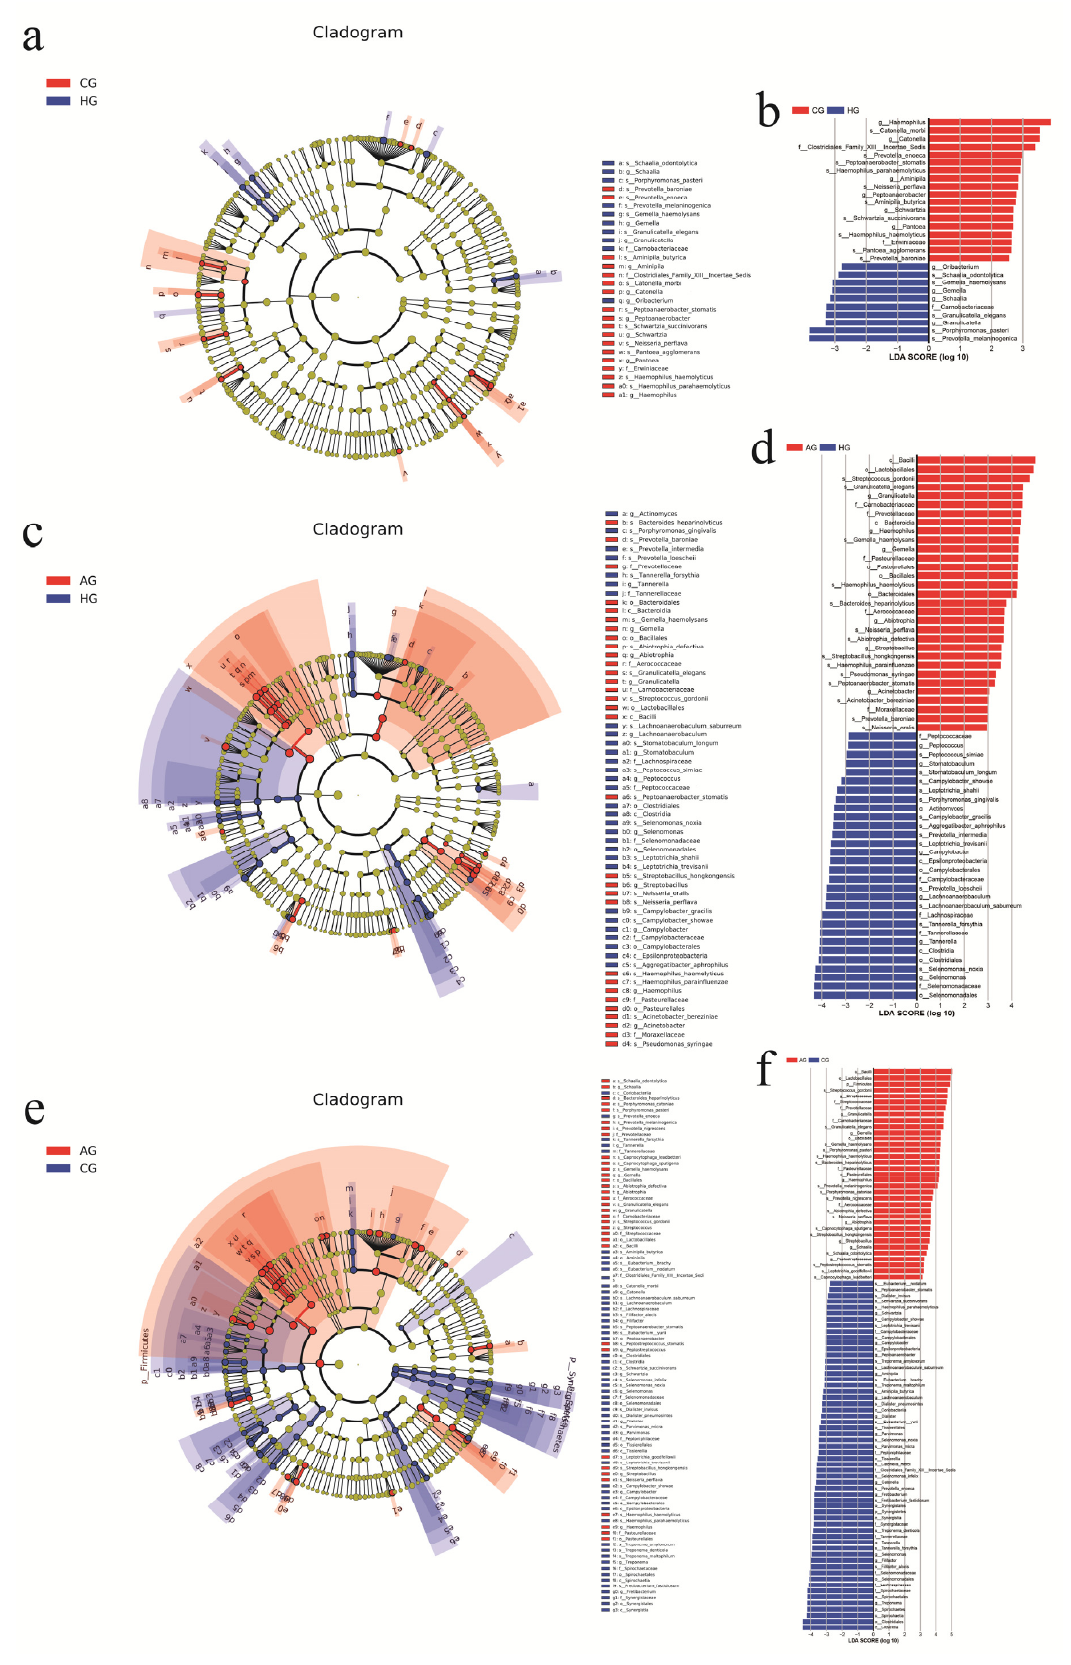
4 Figure 5. Species-difference analysis of different groups. ( a , c , e ) Colors represent different